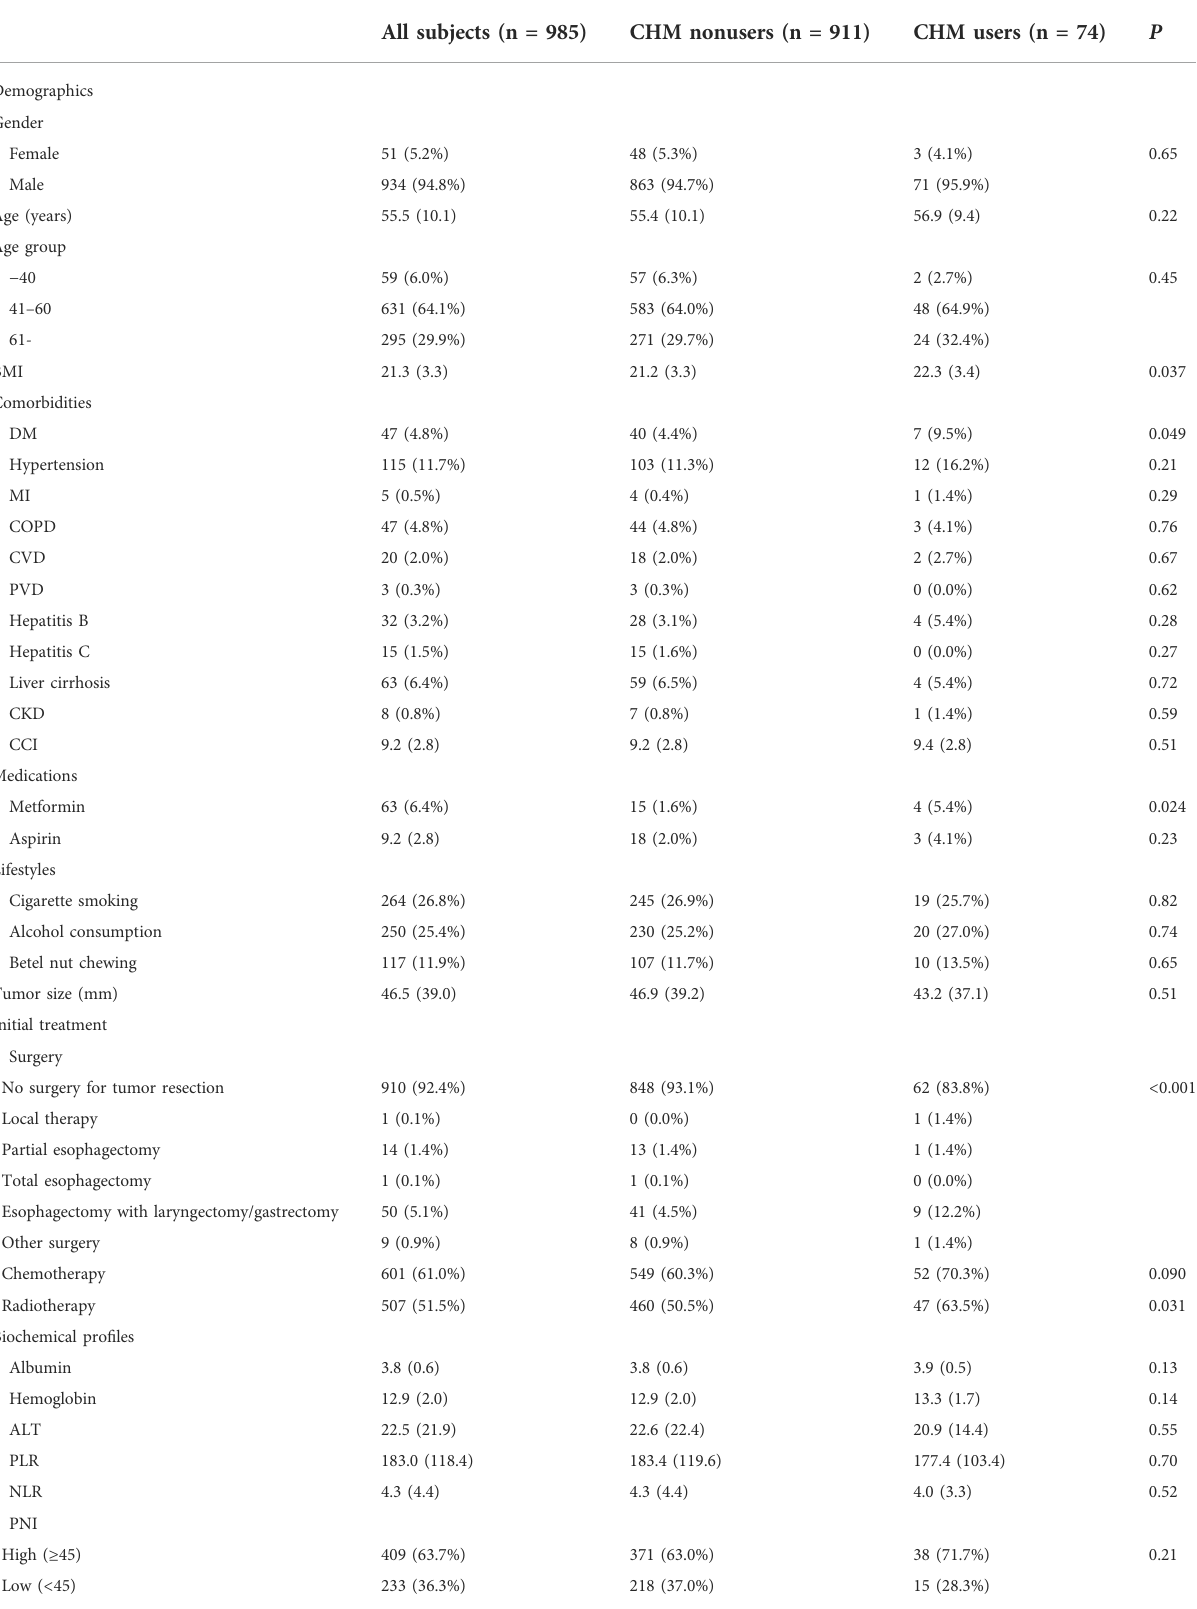
TABLE 1 Baseline features of patients with stage IV esophageal